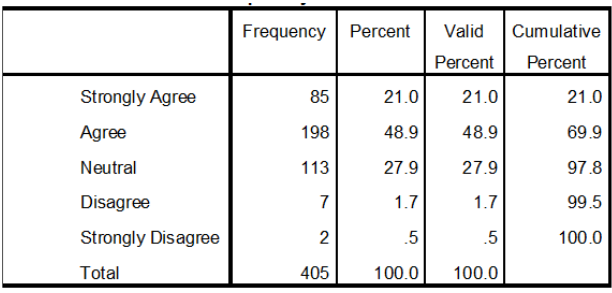
Figure 37. Our cloud and IoT based offerings are secured against all kinds of data and privacy